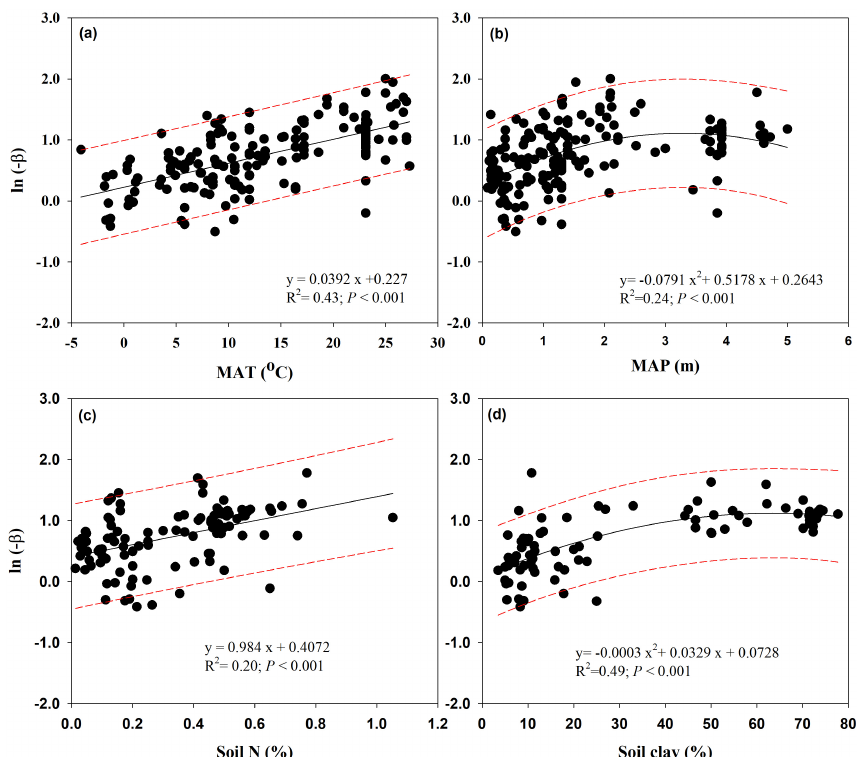
Figure 5. Beta varied with climatic and edaphic factors. Relationships between ln ( − β) and MAT (a) , MAP (b) , soil N (c) , and clay concen- tration (d) for global dataset. Solid line is regression line and dashed lines denote 95% prediction